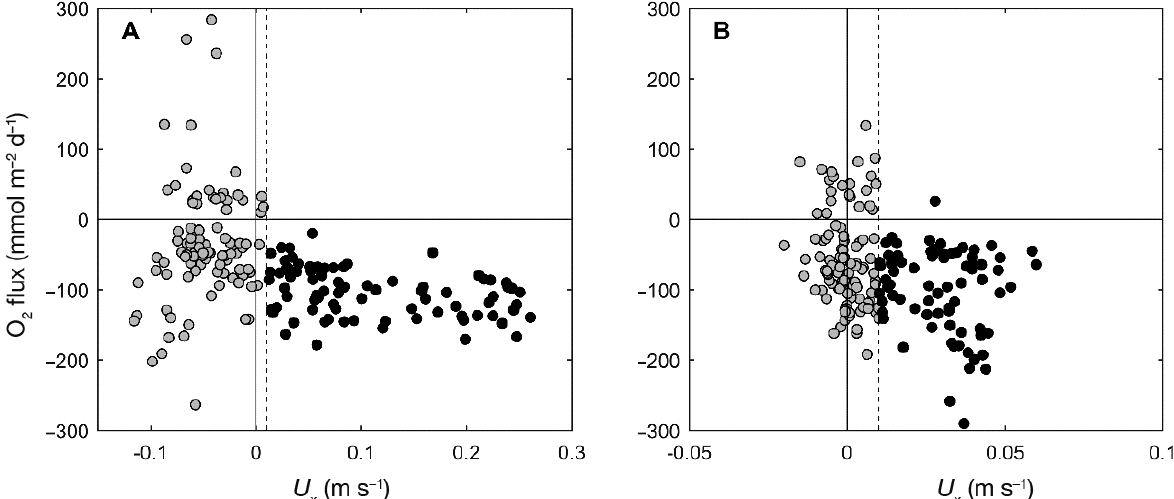
Fig. 5. Fluxes plotted against the velocity component aligned along the axis ( U x ) of the fast-response oxygen sensor at (A) site H3 and (B) site L. Fluxes shown as solid black circles are when the on-axis velocity > 0.01 m s −1 (vertical dashed line)